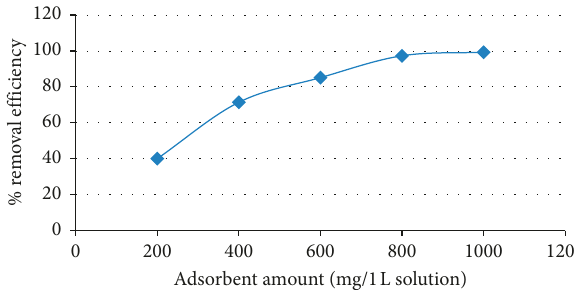
Figure 8: Removal efficiency versus adsorbent amount. Initial dye concentration 25mg/L, pH of the solution (cid:30) SDS amount 100 mg/1L solution. (cid:30)